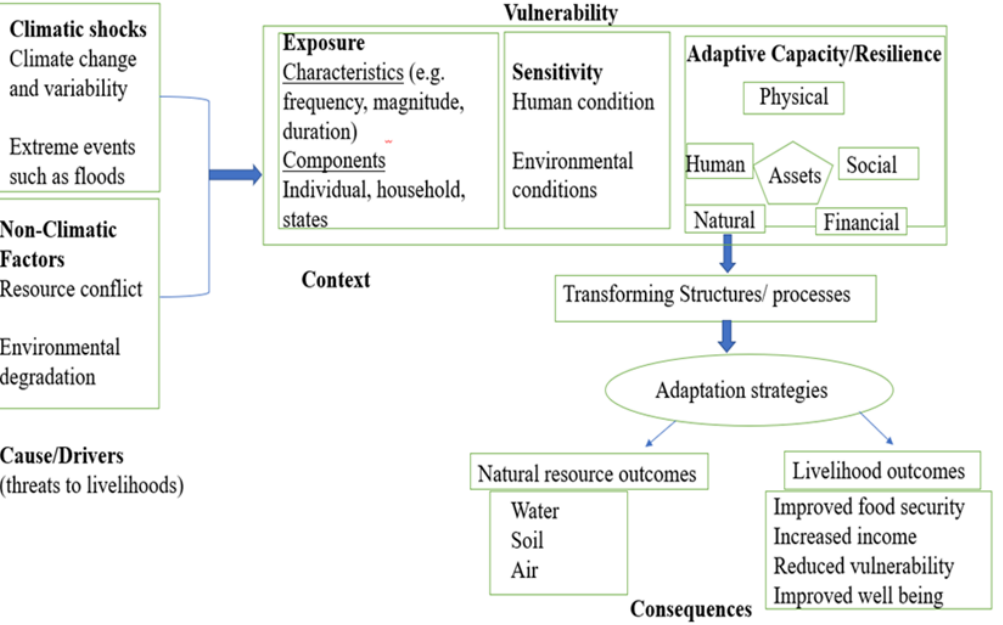
Figure 1. Conceptual framework linking climate shocks, environmental degradation, and resource conflict in contexts of vulnerability and food security. Adapted from [32,33] .